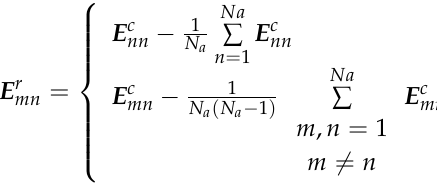
Figure 4. Calculated SAR value at sample frequency of 0.9 GHz using 1 mW transmission power.